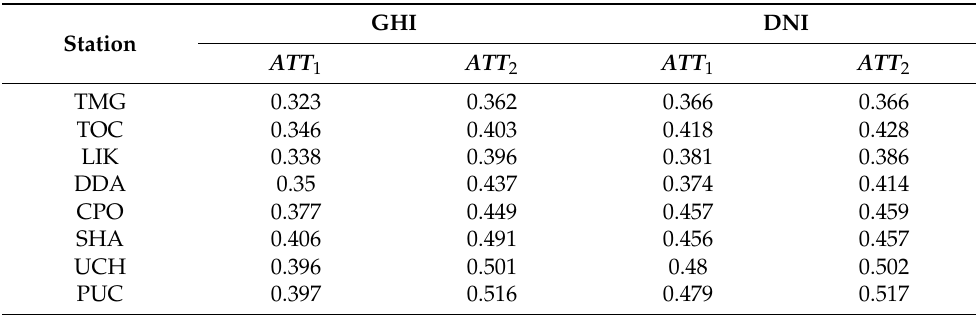
Table 5. GHI and DNI measured attenuations, comparing the results of the two attenuation defini- tions employed in this